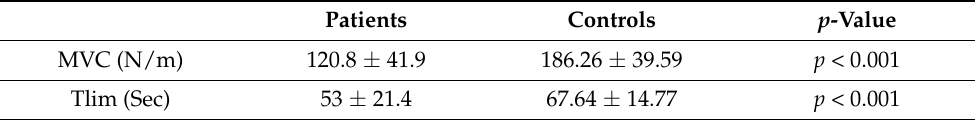
Table 4. Muscular strength and endurance time.